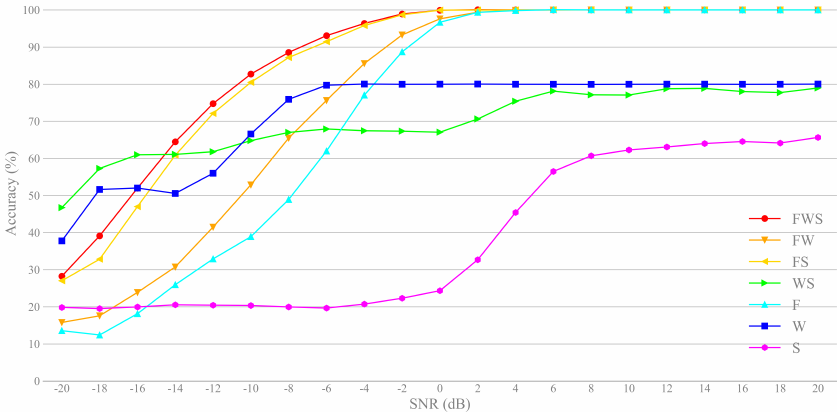
Figure 6. Classification accuracy vs. SNR for different